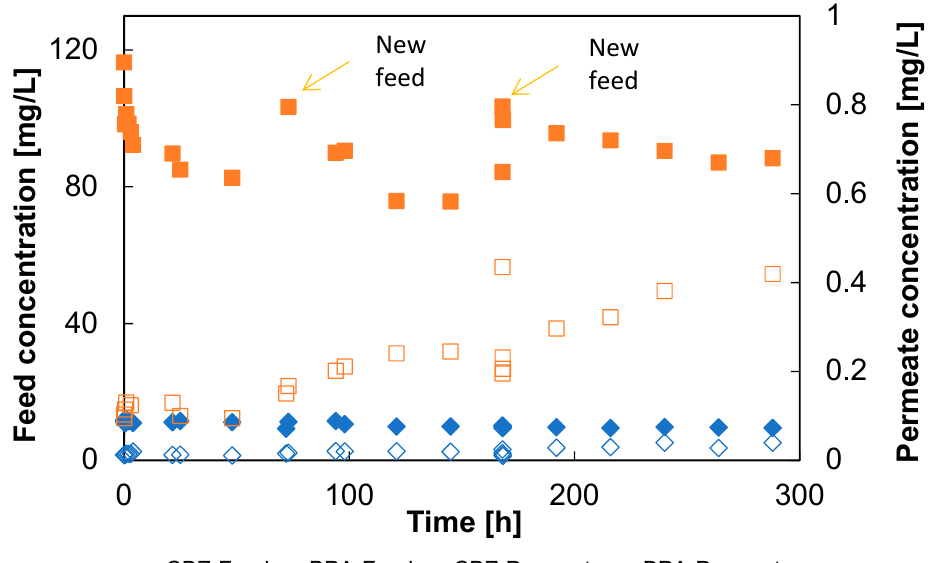
Figure 5. Changes in the feed and permeate concentrations of carbamazepine (CBZ) and bisphenol-A (BPA) measured with time for a pristine ESPA1-2521 element. The filled and open symbols represent the feed and permeate concentrations, respectively.